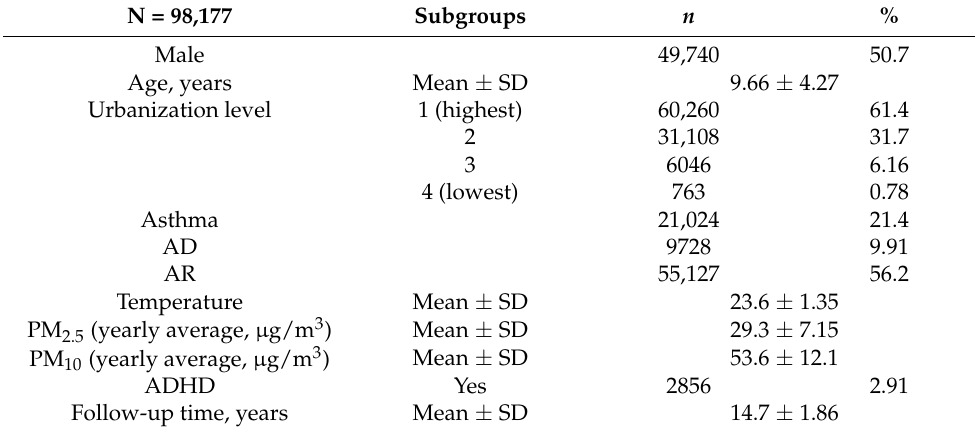
Table 1. Baseline demographics and exposure to air pollutants determined using yearly average concentration in Taiwan, 2003–2017.